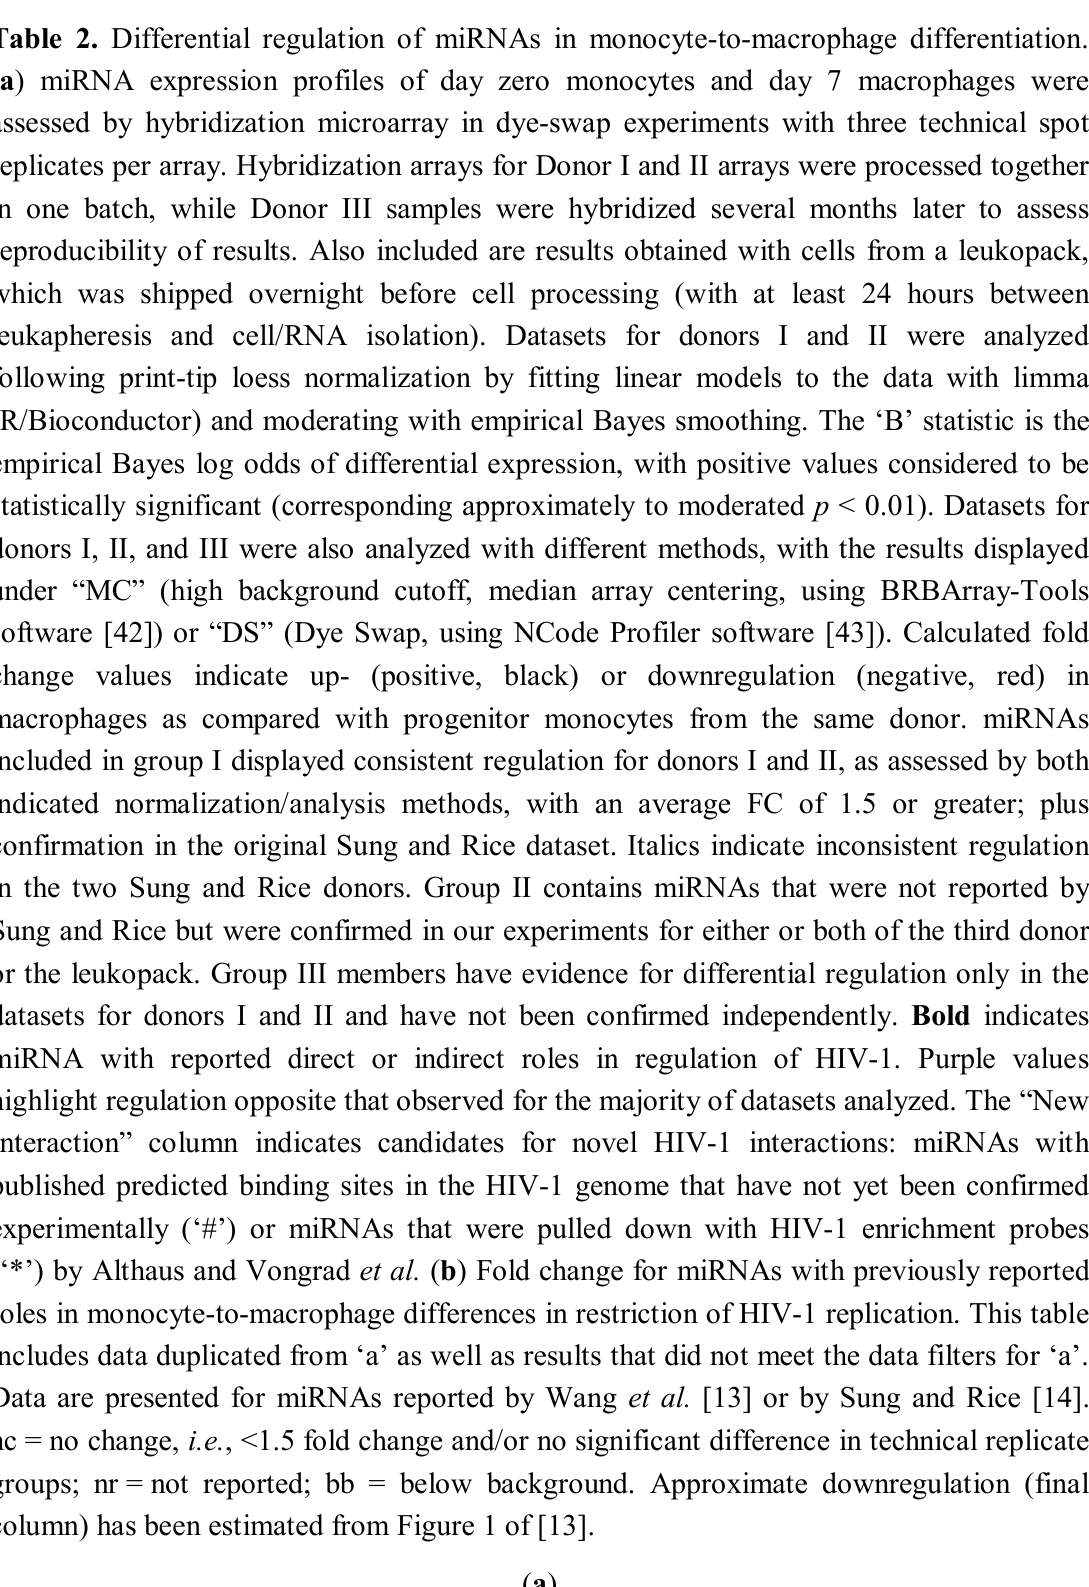
Table 2. Differential regulation of miRNAs in monocyte-to-macrophage differentiation. ( a ) miRNA expression profiles of day zero monocytes and day 7 macrophages were assessed by hybridization microarray in dye-swap experiments with three technical spot replicates per array. Hybridization arrays for Donor I and II arrays were processed